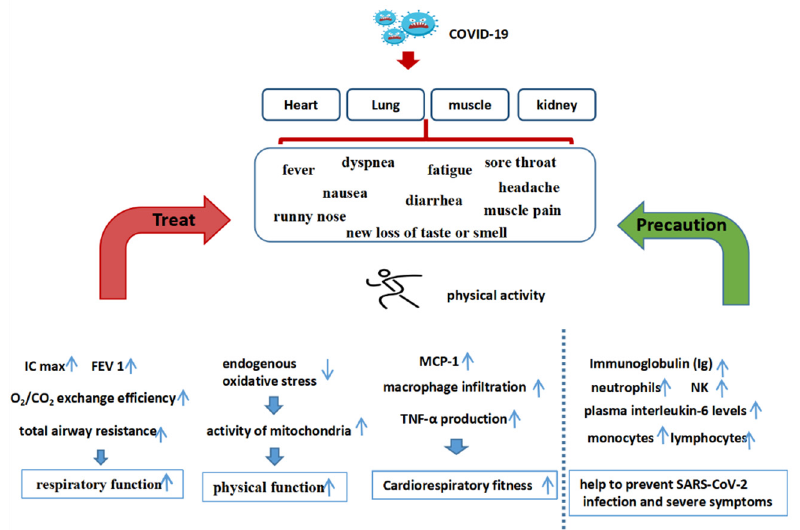
Figure 2. The impact of sports before and after COVID-19.